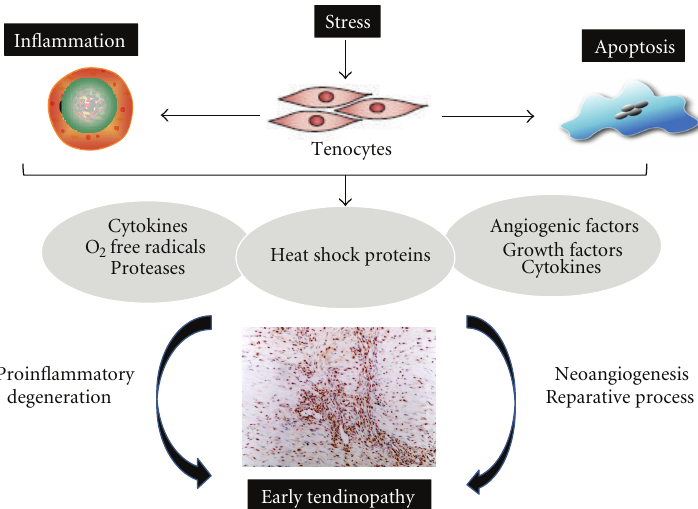
Figure 3: Overview of heat shock biology in tendinopathy. Schematic diagram illustrating the manner in which early tendinopathy may arise due to HSP release. An increase in stress that a tendon cell experiences results in the release of various inflammatory mediators and associated HSPs that interact to drive the tendon matrix toward a degenerative or reparative